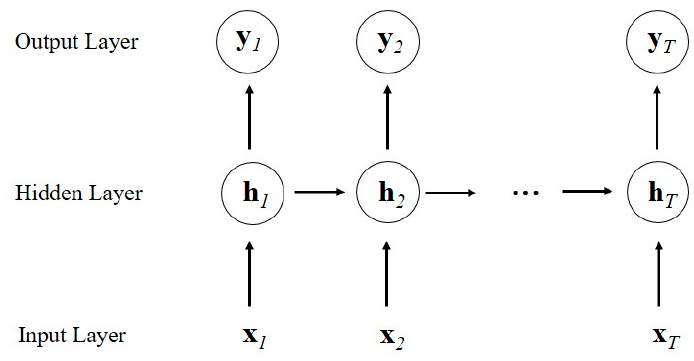
Figure 3. Framework of a simple RNN model.